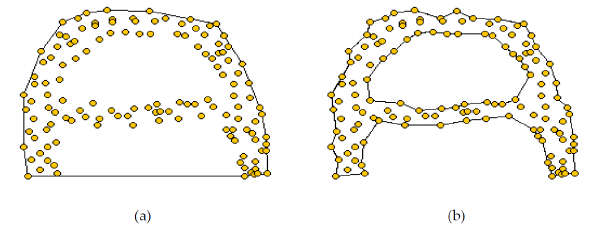
Figure 2. Example of polygons obtained via the concave hull (a) and convex hull (b). Franois Blair